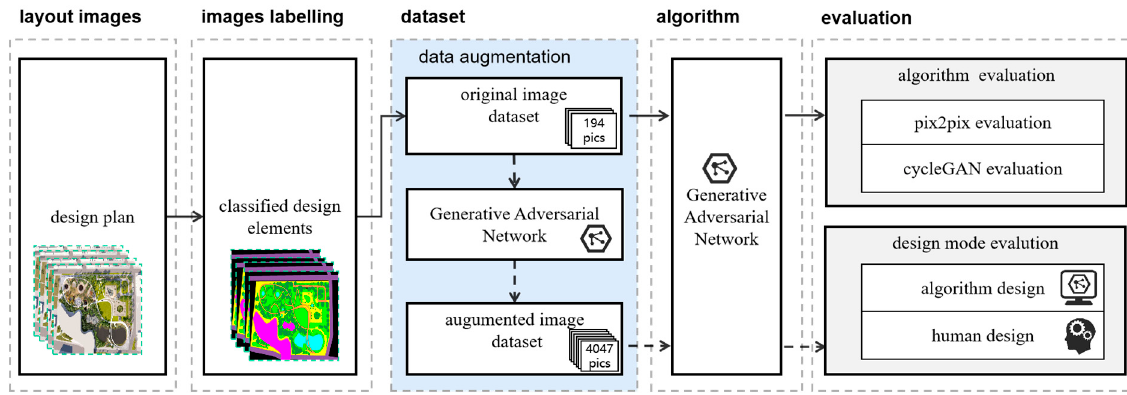
Figure 2. Research Framework.